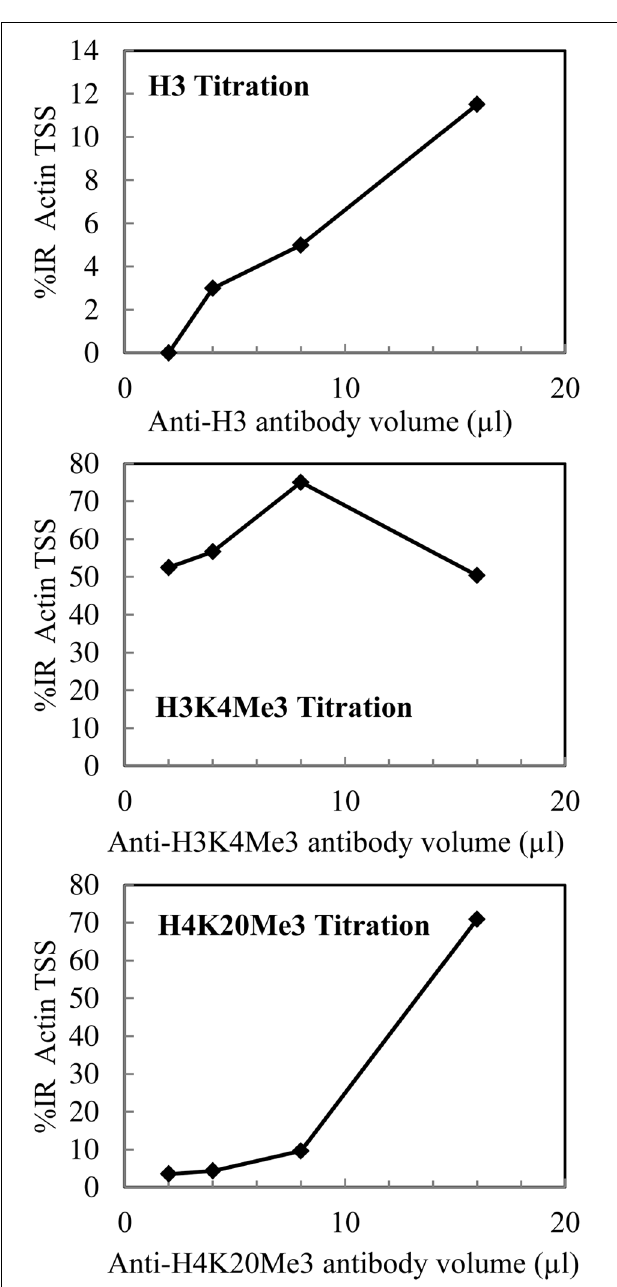
FIGURE 4 | qPCR on M. incognita chromatin that had been immuno-precipitated with various volumes (0–16 µ l) of Anti-H3, Anti-H3K4Me3, and Anti-H4K20Me3 antibodies (1 µ g/ µ l). The amount of target DNA recovered in the immune-precipitated fraction was quantified by calculating the percent input recovery (% IR) normalized with the percent input recovery obtained with the housekeeping gene as previously described by Cosseau et al.